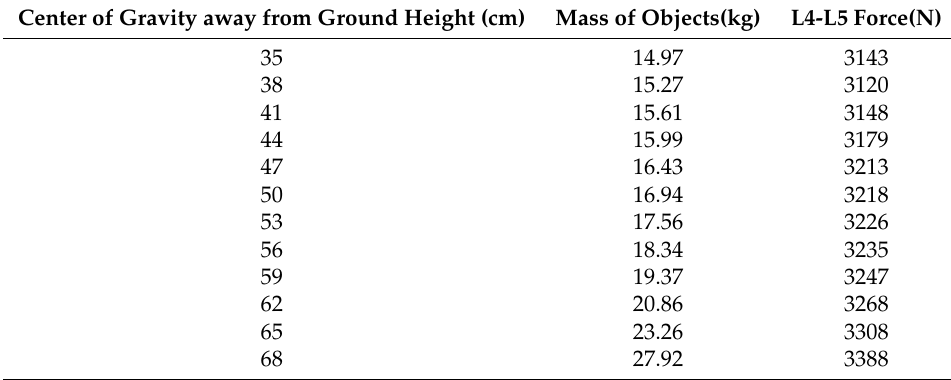
Table 3. L4-L5 stress in the software simulation